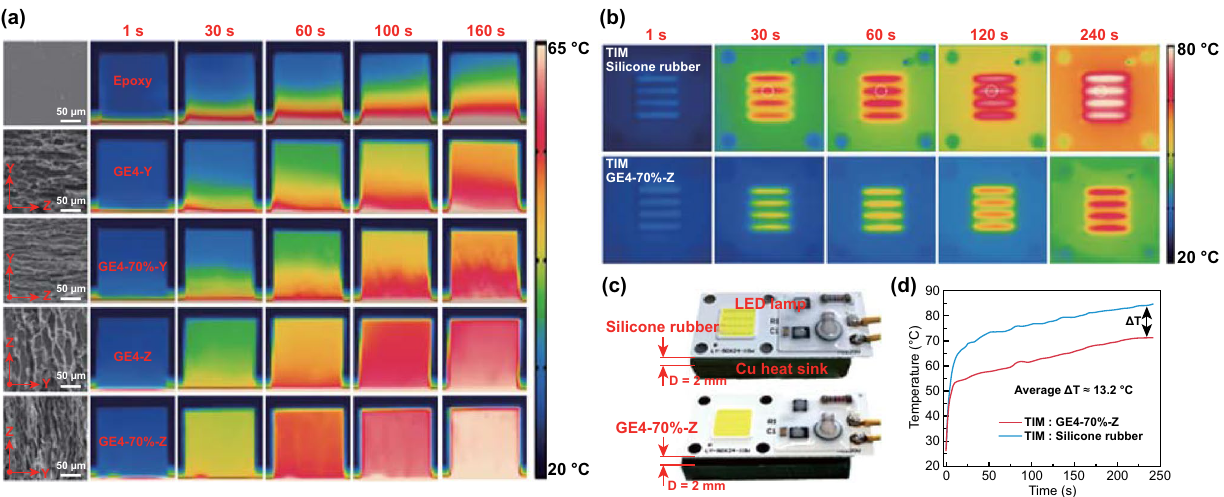
Fig. 5 a Infrared images of epoxy and its composites on the same hot stage at 75 °C, showing that GE4‑70%‑Z has the best thermal conduc‑ tion efficiency. SEM images in the left column show the morphologies of epoxy and composites. b Top‑view infrared images of the LED chips during working, indicating more efficient heat dissipation when GE4‑70%‑Z is used as TIM. c Digital photographs showing two LED chips integrated with commercial silicone rubber and GE4‑70%‑Z as TIMs. d Comparison between the temperature increases in the same plot on two chips, depicted by the white dotted circle in b